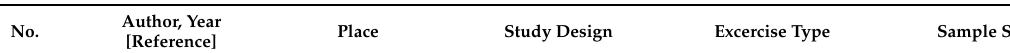
Table 1. General characteristics of the included